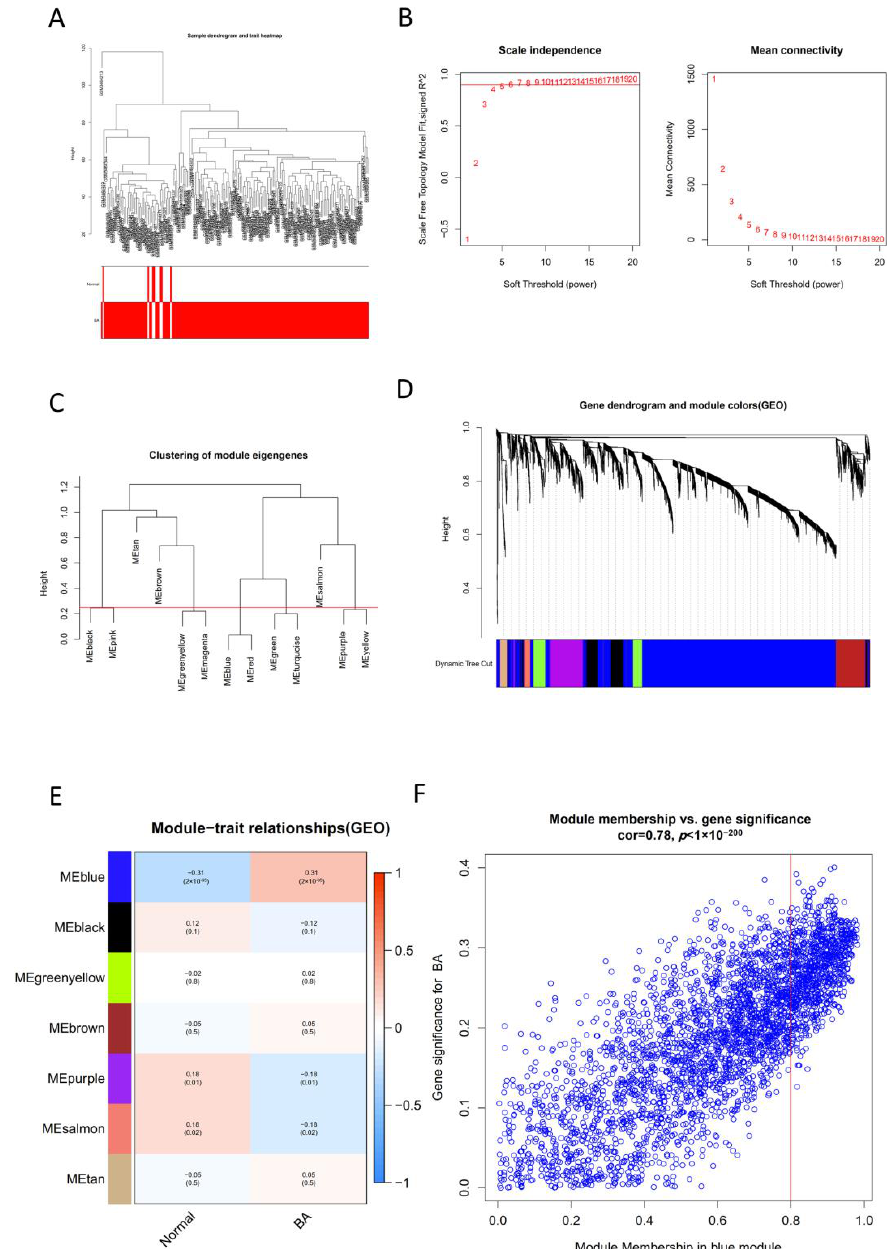
Figure 3. Correlated key module construction with BA through WGCNA. ( A ) Sample clustering dendrogram of the GSE122340. ( B ) Clustering dendrograms of genes. Analysis of the scale-free fit index ( left ) and the mean connectivity ( right ) for various soft-thresholding powers. ( C ) Dendrogram of all differentially expressed genes (DEGs) based on a dissimilarity measure. ( D ) An eigengene dendrogram identified groups of correlated modules. ( E ) Module–trait relationships between genes and clinical traits of BA. Each cell contains the correlation coefficient and p -value. ( F ) Scatter plot of gene significance in the blue